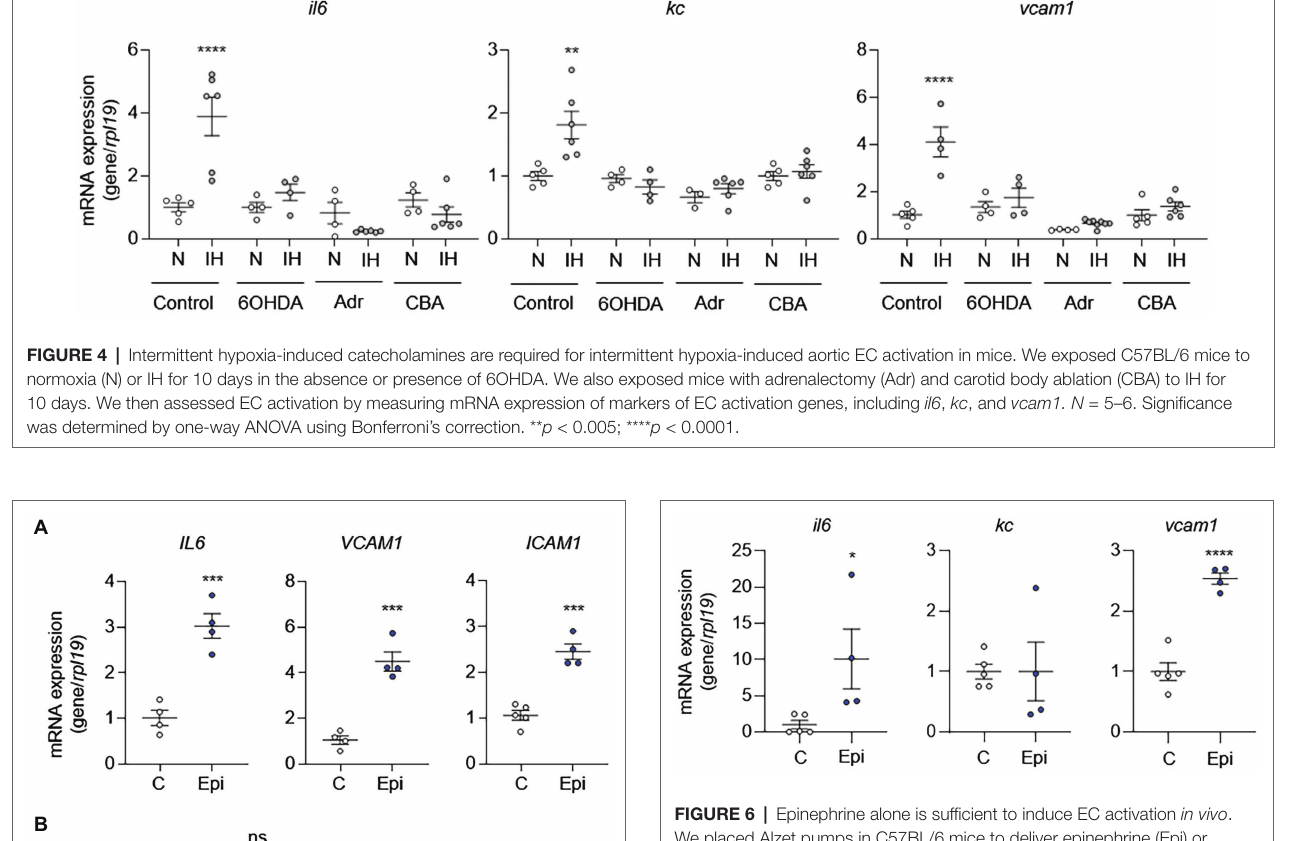
FIGURE 6 | Epinephrine alone is sufficient to induce EC activation in vivo . We placed Alzet pumps in C57BL/6 mice to deliver epinephrine (Epi) or control vehicle (C) continuously for 10 days. We then assessed EC activation by measuring mRNA expression of markers of EC activation genes, including il6 , kc , and vcam1. N = 4–5. Significance was determined by Student’s t -test. * p < 0.05; **** p <